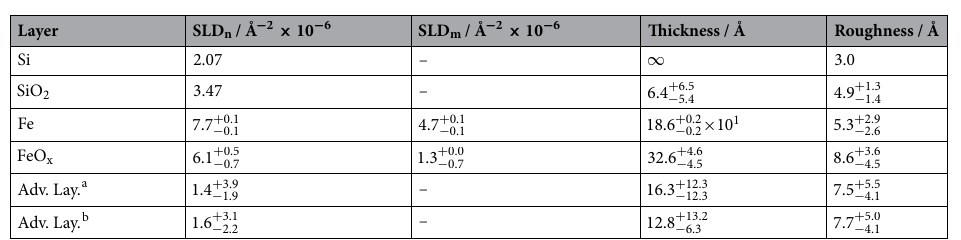
Table 1. Fitted layer parameters for dodecane- d 26 entrained against an iron-coated silicon substrate at 7.0 × 10 2 s − 1 . The central parameter values are the median values obtained from the bootstrap routine, with the 95% confidence intervals reported in the sub- and superscripts. Those values without uncertainties were held constant. a Parameters used to model the sheared layer. b Parameters used to model the non-sheared layer.